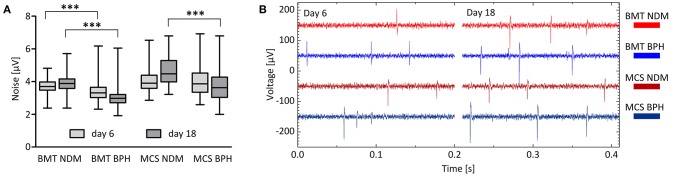
Noise in each MEA type and medium combination. (A) Estimation of the standard deviation of background noise of each MEA type and medium combination at two time points. Data are expressed as the median (band inside the box) with interquartile range (IQR; box) and minimum and maximum values (whiskers) at two time points: 6 and 18 days on MEA. BMT, BioMediTech MEA; MCS, Multi Channel Systems MEA; NDM, neuronal differentiation medium; BPH, BrainPhys medium. ***p ≤ 0.001. In addition, the noise level of BMT MEAs was significantly lower from that of MCS's sputtered TiN MEAs under the same time point and condition (p < 0.001 for all). (B) Examples of raw measurement data of each MEA type and medium combination at two time points. Curves have been shifted vertically for clarity.